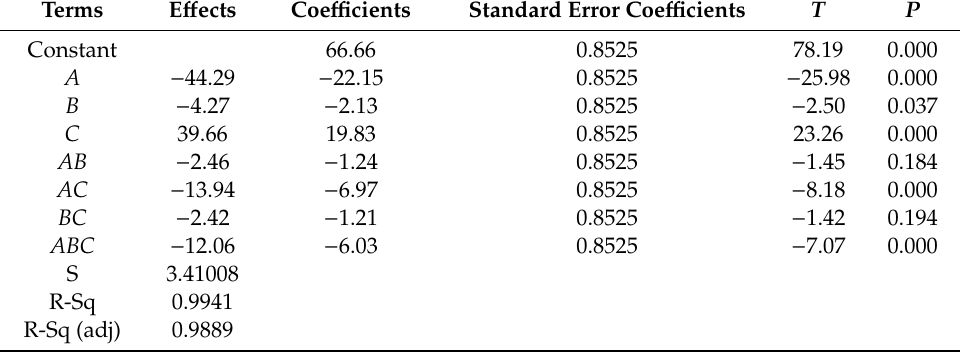
Table 4. Statistical parameters for 2 3 -factorial design of experiments.